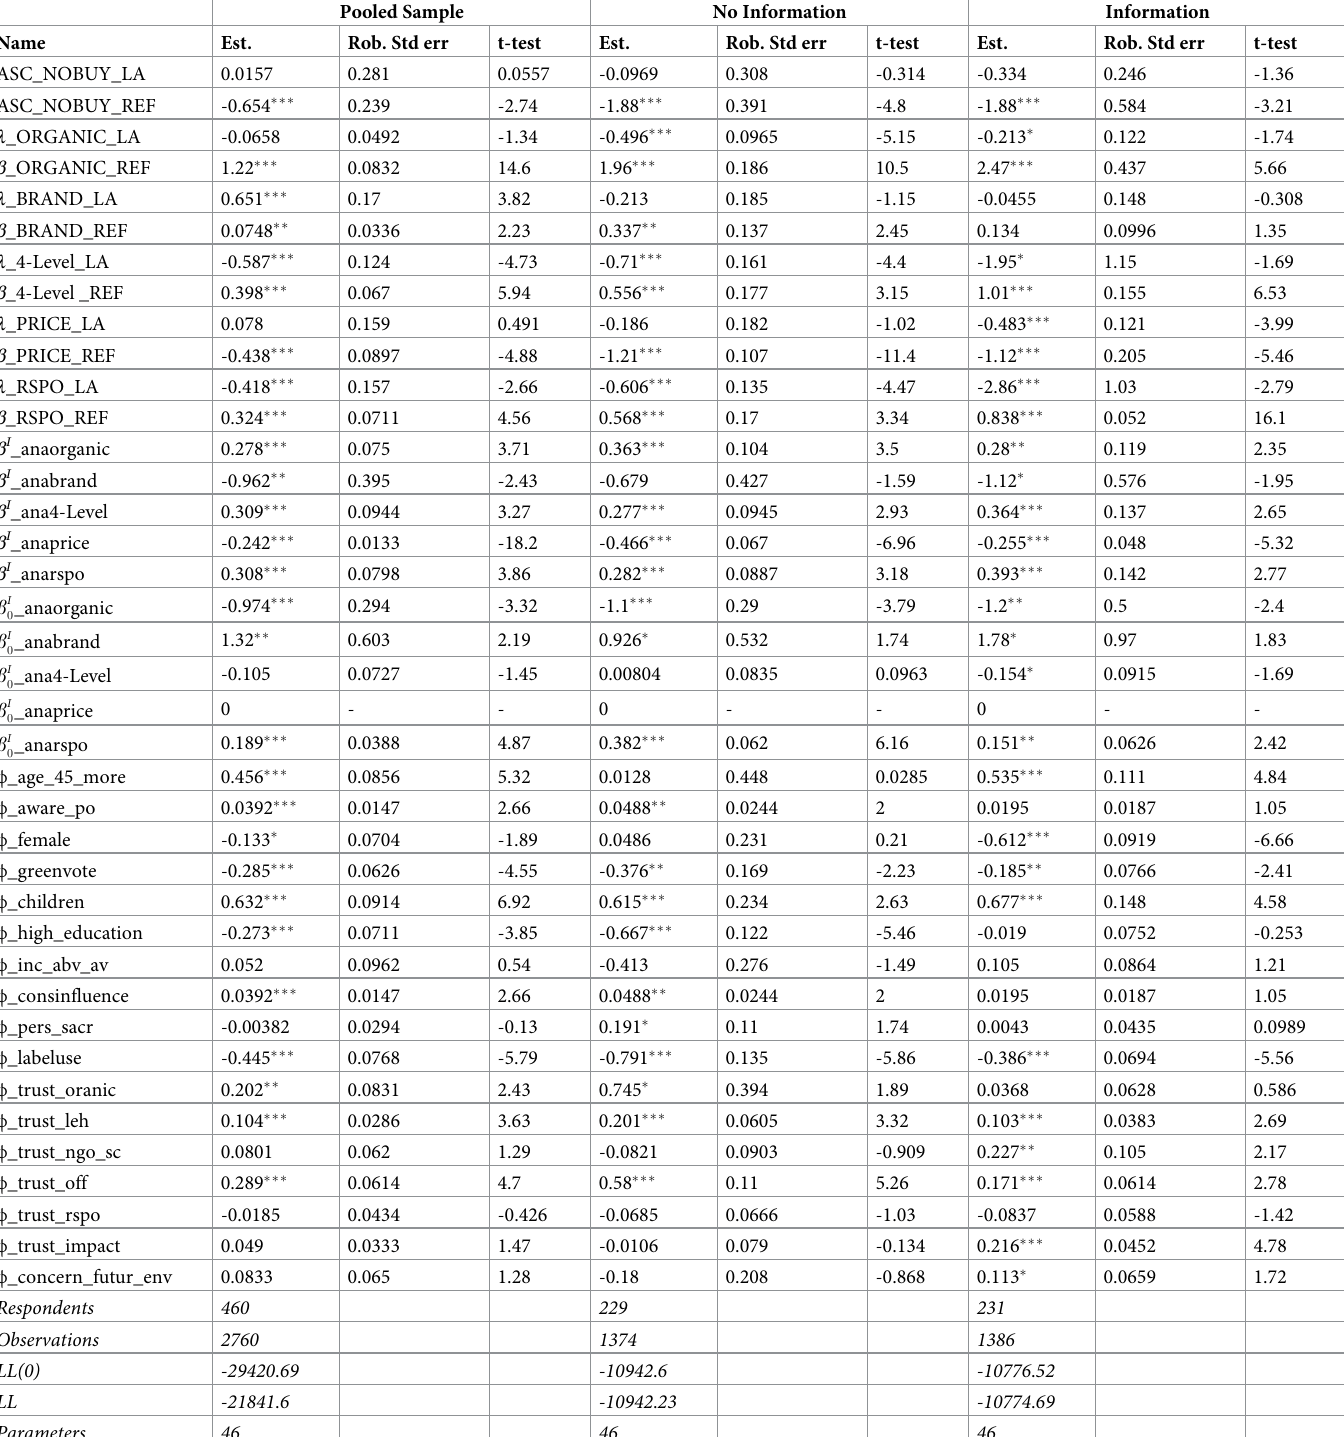
Table 5. Maximum likelihood estimates pooled sample, information, and no information treatments. Pooled Sample No Information